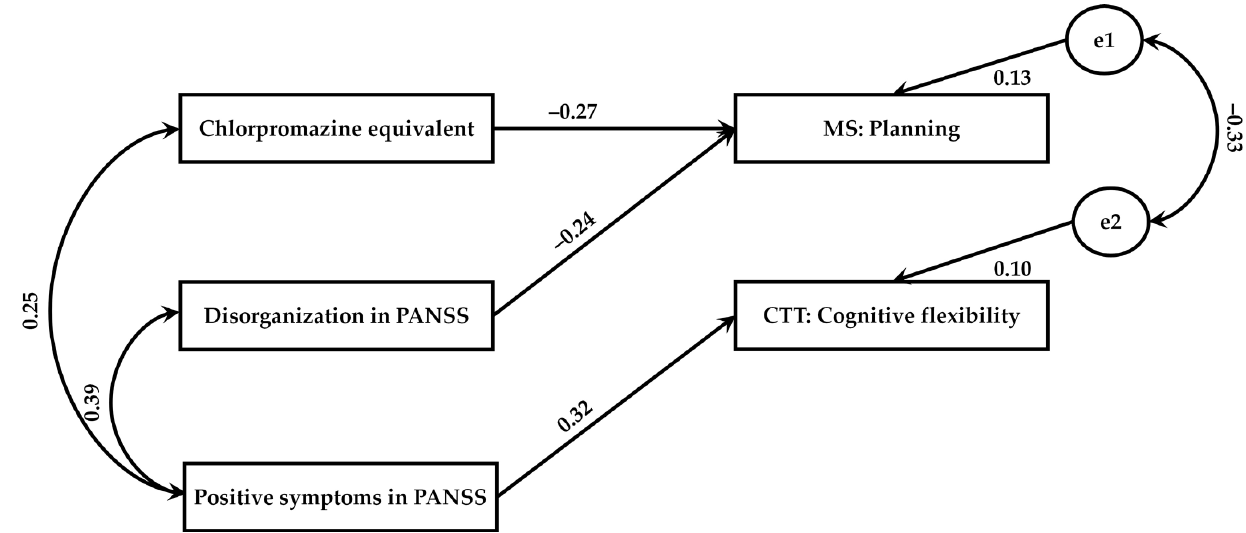
Figure 4. Clinical factors and psychopathological symptoms as predictors of executive functions in NDS patients; e1–e2 depict the error term referring to the dependent variables.